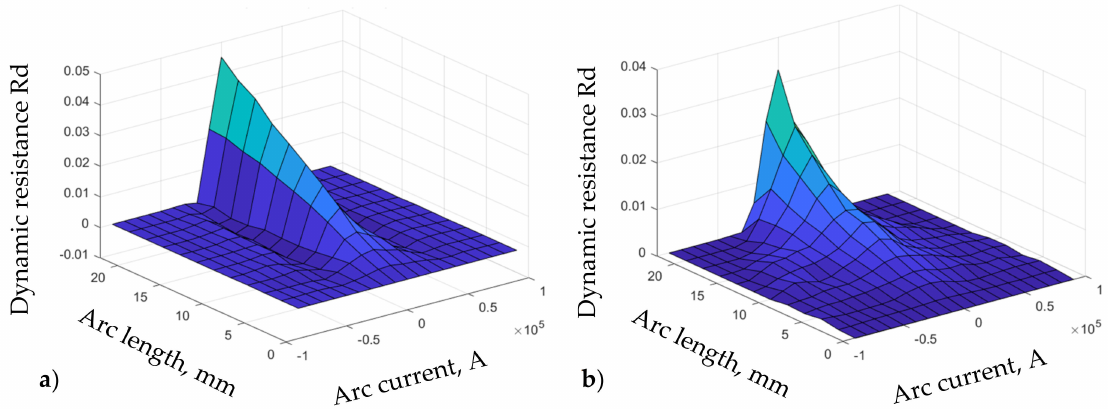
Figure 3. Dependences of dynamic resistance change of R d ( I arc , l arc ) for different curves of dynamic Volt-Ampere characteristic: ( a )—for current increasing, ( b )—for current decreasing.